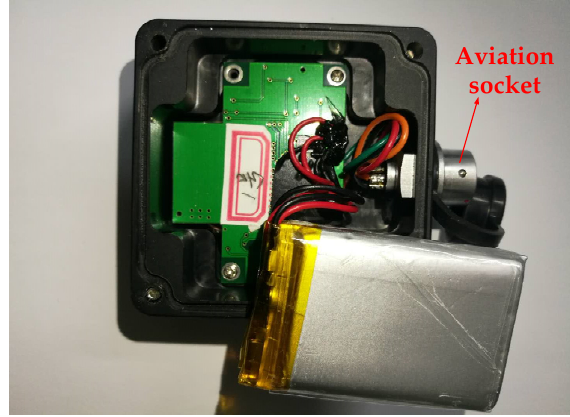
Figure 10. Internal view of sensor’s case before glue filling.